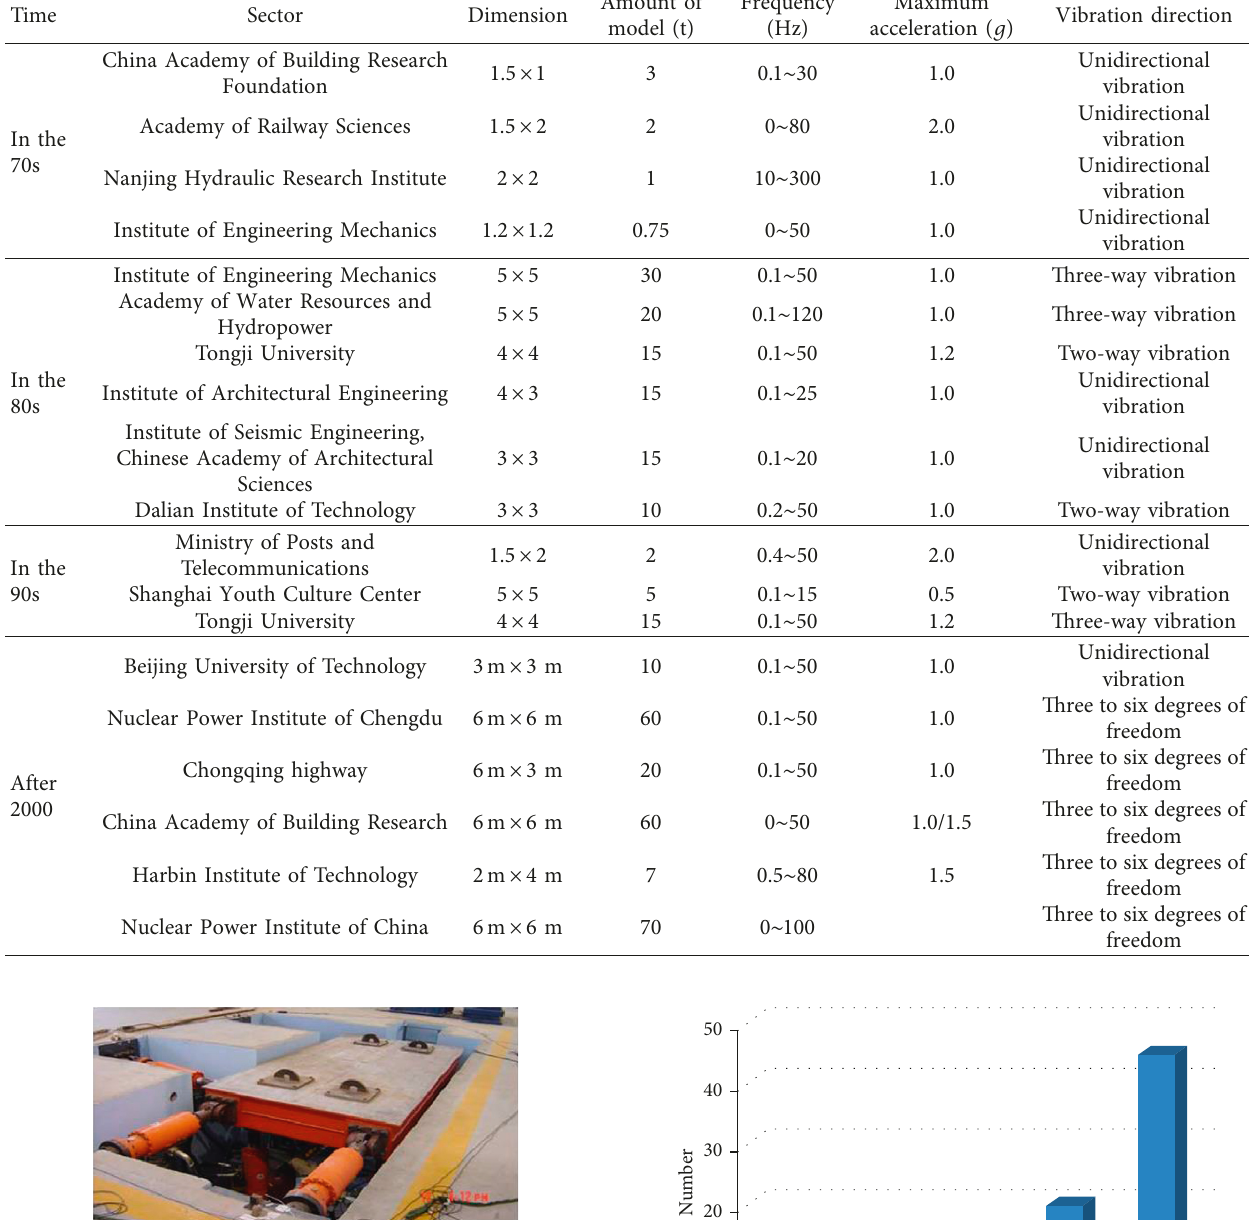
Table 1: Shaking table construction in